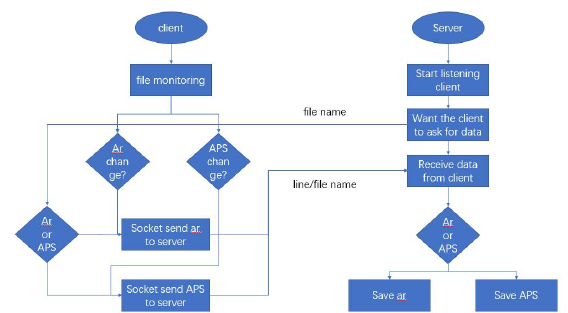
Figure 8 . Flowchart of data transmission